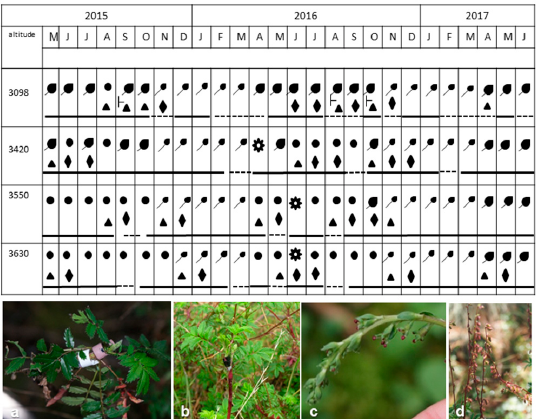
to 1 µ m thick for Alchemilla and 2 to 3 µ m thick for Acaena and Ribes were cut in a rotary microtome (RM2125 Leica, Westlar, Germany), stained with cresyl violet—following the method of Zarlavsky [43]—and mounted with synthetic resin (Hycel, Monterrey, Mexico). Figure 1. Phenology and cambial activity of Alchemilla procumbens over the altitudinal gradient, We considered the vascular cambium to be active when there were divisions towards the phloem or xylem, very thin walls and mitotic figures were detected [15,44,45]. The cambium was inactive when there were no divisions, the fibers in the xylem had a narrower radial diameter and thicker walls, and the sieve tube elements in the phloem were partially collapsed, with a greater callose abundance also being observed.